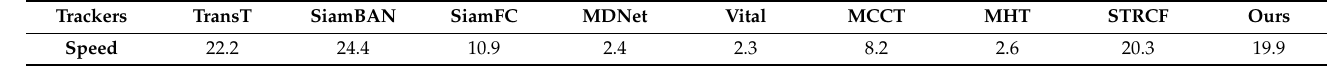
Table 7. Comparison the running time on IMEC16.